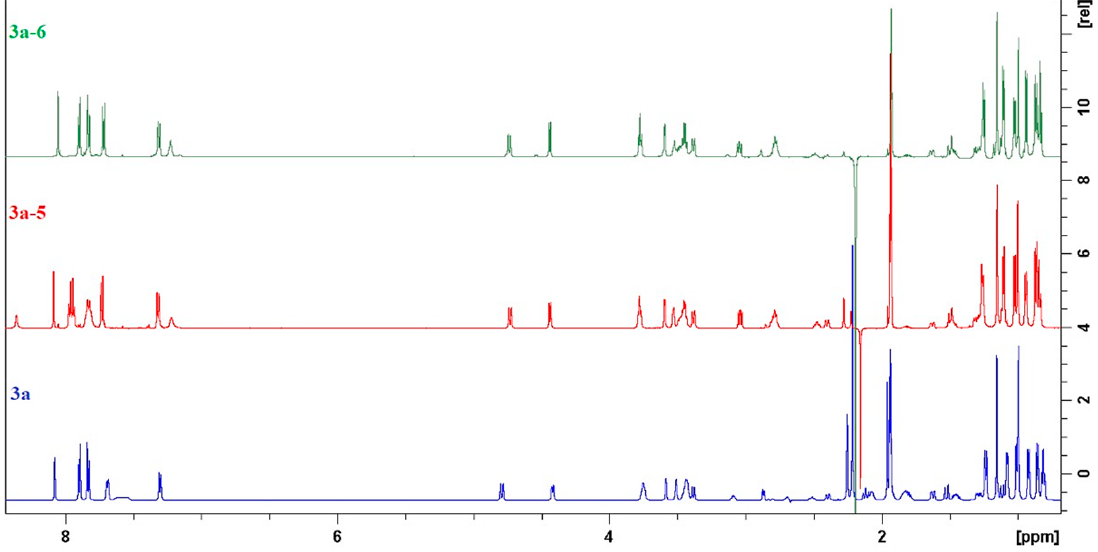
Figure 5. Proton NMR spectra of 3a (blue), 3a-5 (red) and 3a-6 (green).